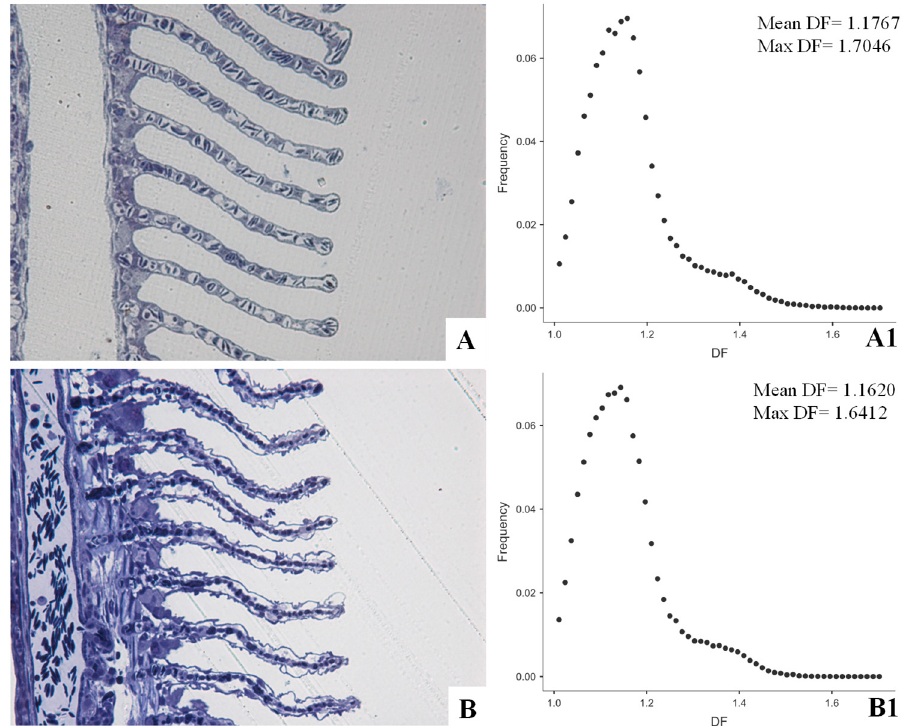
Figure 1. European sea bass, Dicentrarchus labrax (Linnaeus, 1758). Epon-Araldite embedded semithin sections stained with Toluidine Blue and observed at light microscopy. Secondary gill lamellae from normal ( A ) and Cd exposed ( B ) exemplars. Cadmium exposure affects both water–epithelial cell interface, where lifting, shrinkage and curling of epithelial cells are appreciable, and pillar cell–blood interface, where pillar cells (gill modified endothelial cells) coarctation results. Morphological evident alterations affect tissue complexity as measured by fractal dimension in binarized, outlined figures. Testing previous tissues for Local Connected Fractal Dimension (LCFD) results in the two scatter plots of frequency (ordinates) to fractal dimension (DF) (abscissa) ( A1 , B1 ). Accordingly, Cd exposure affects mean and maximal fractal dimension. Moreover, a slight left shift of the scatter plot is appreciable compared to normal tissue, resulting in a significant difference (Wilcoxon W, p < 0.05) in the paired frequencies. Further information, details about the application of LCFD analysis to gill pathology and about the histopathological, and ultrastructural effects of Cd exposure on European sea bass gills are available in Manera et al.